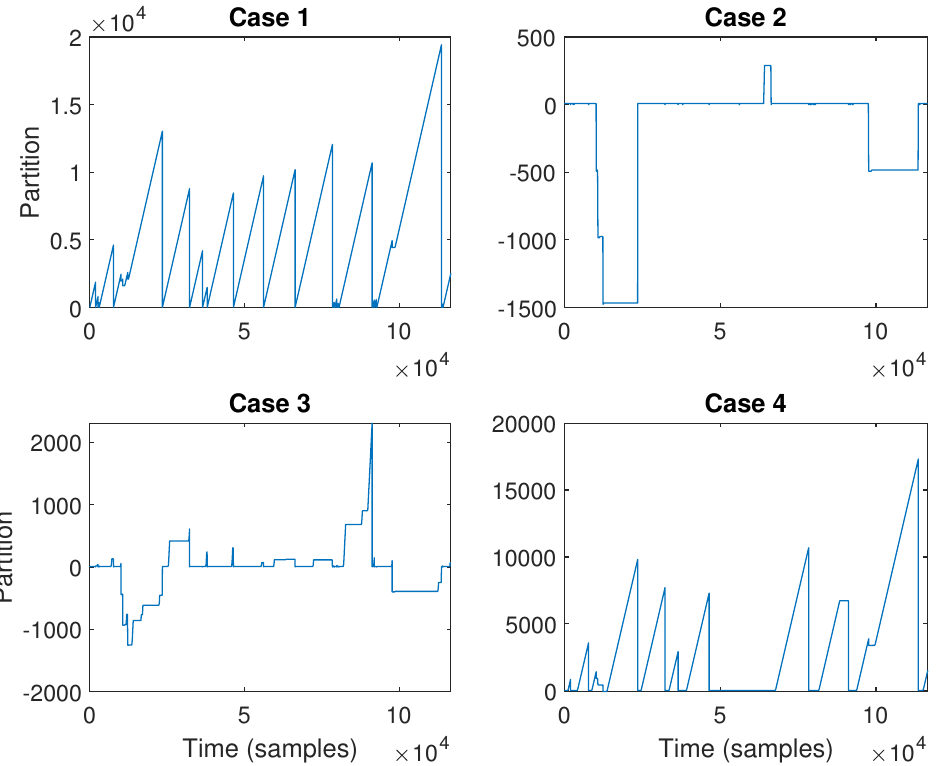
Figure 5. Data Segmentation for ( top left ) Case 1, ( top right ) Case 2, ( bottom left ) Case 3, and ( bottom right ) Case